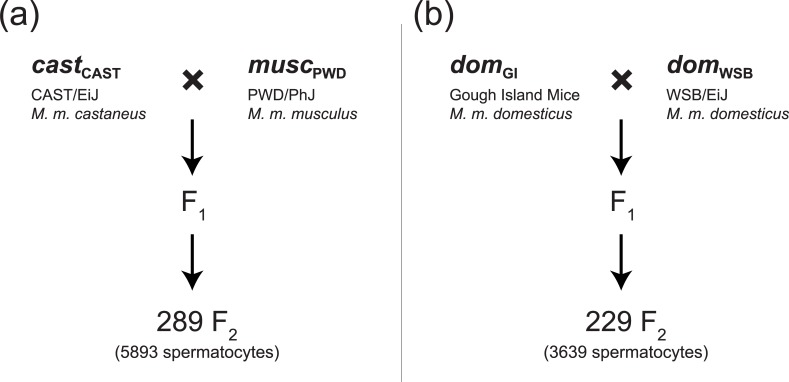
Cross design.Diagram of the intercross design using wild-derived strains (a) between subspecies of M. m. musculus and M. m. castaneus, represented by castCAST and muscPWD, and (b) within subspecies of M. m. domesticus, represented by domGI and domWSB. F2s in both crosses are a mix from reciprocal cross directions. The abbreviations for each strain in bold are used throughout.